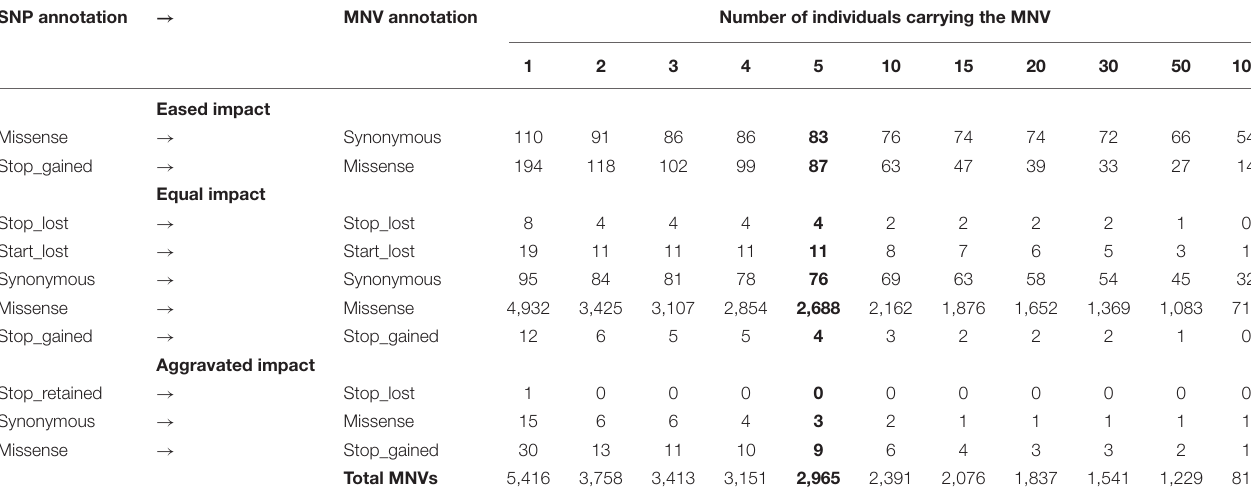
FIGURE 2 | Workflow of MNV detection in coding regions and functional consequence prediction. Left: MNV detection from 3.3M SNPs previously identified using RNA-seq of 382 chickens (companion article; Jehl et al., 2021). Right: MNV constituent SNP selection and protein impact selection of these SNPs separately analyzed by VEP. TABLE 1 | Occurrences for each type of re-prediction according to the number of individuals carrying the